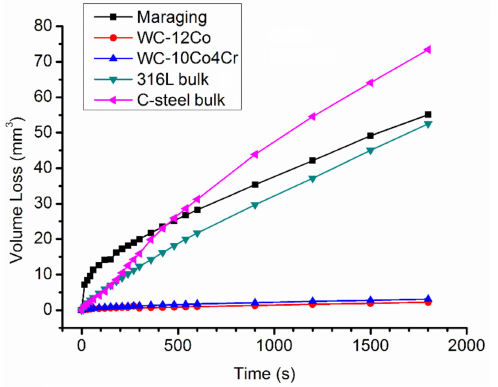
Figure 8. Accumulated volume loss from abrasion